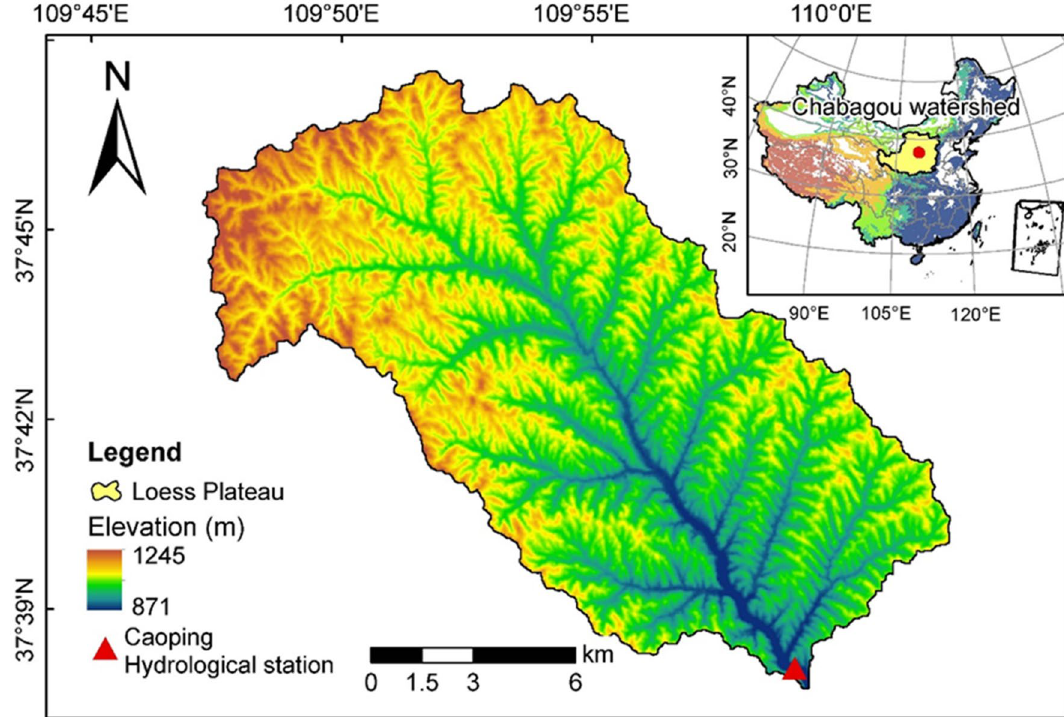
Figure 1. Map of the Chabagou watershed. The map was generated with ESRI ArcMap 10.5 software (http:// www. esri. com/ arcgis/) with terrain data acquired from the Advanced Land Observing Satellite (ALOS) Phased Array type L-band SAR (PALSAR) Radiometric Terrain Corrected high-resolution dataset 42